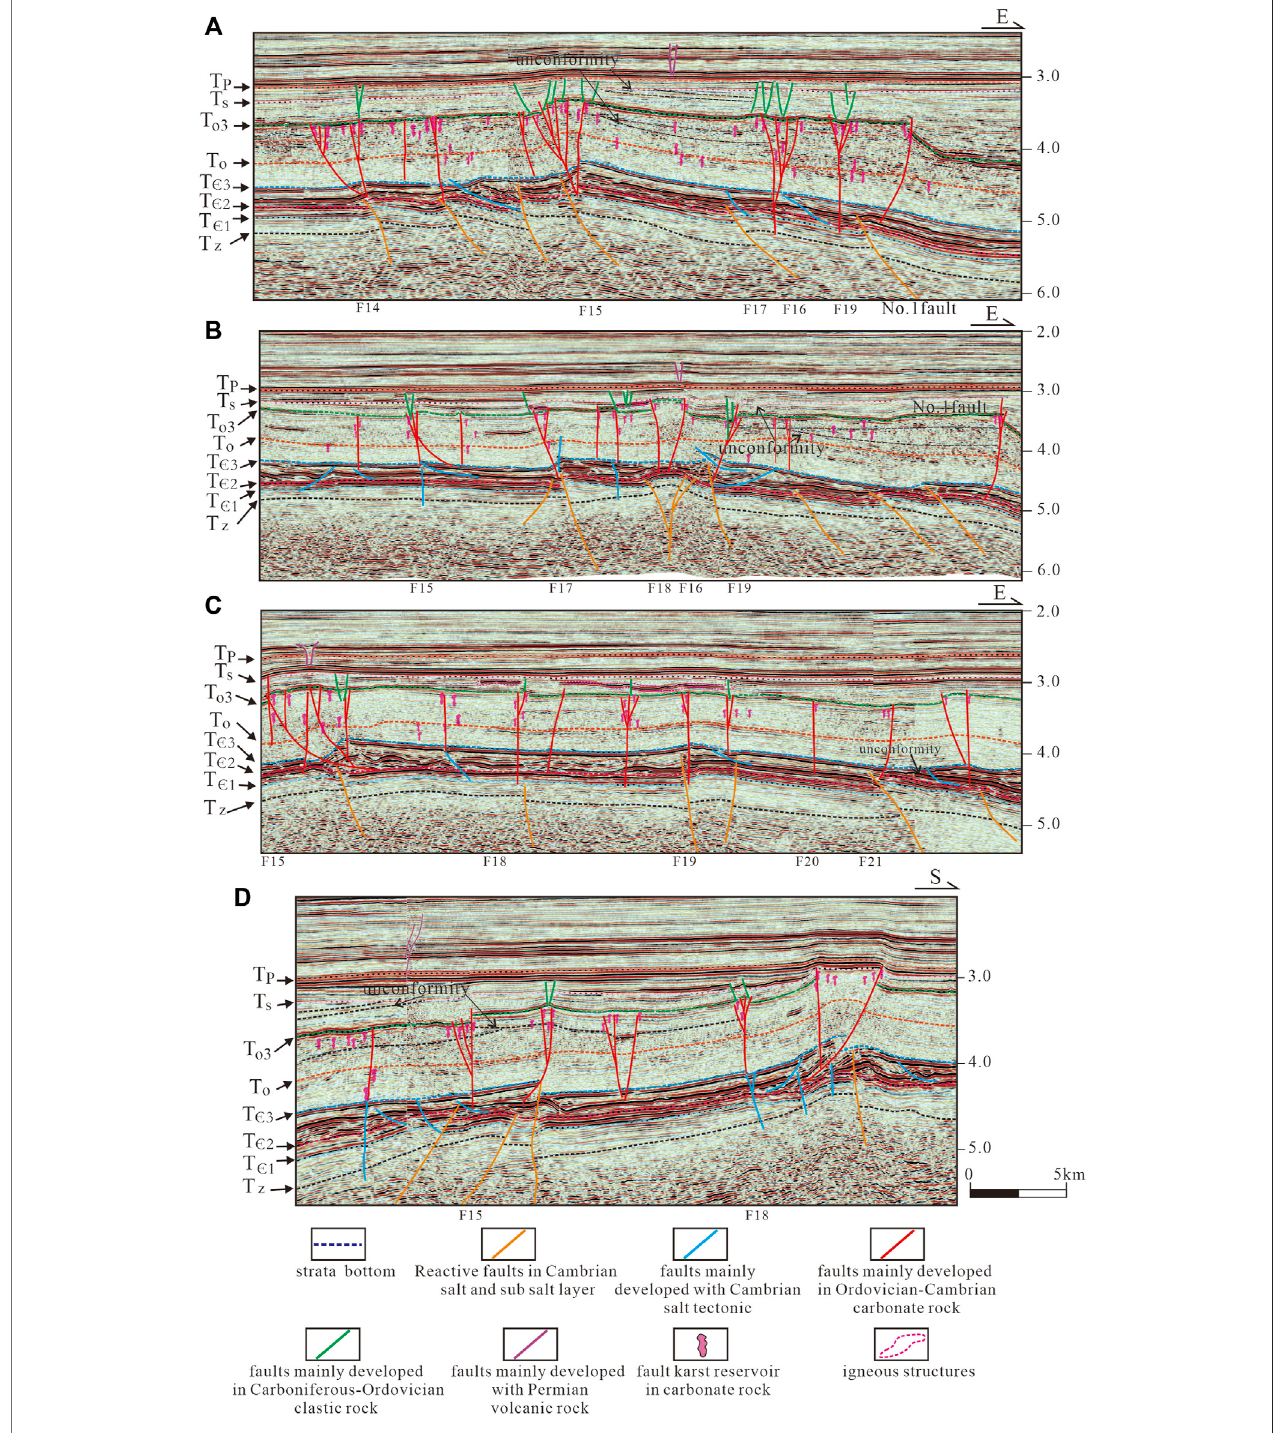
FIGURE12| 3Dseismicpro fi lesoftheTazhonguplift(forlocation,see Figure11 ): (A) 3Dseismiclineofthenorthernpart(L-4), (B) 3Dseismiclineofthecentralpart (L-5), (C) 3Dseismic lineofthesouthernpart(L-6),and (D) 3DseismiclinealonganS – Ndirection(L-7).Pleaserefertothesupplementary materials fortheuninterpreted seismic data.